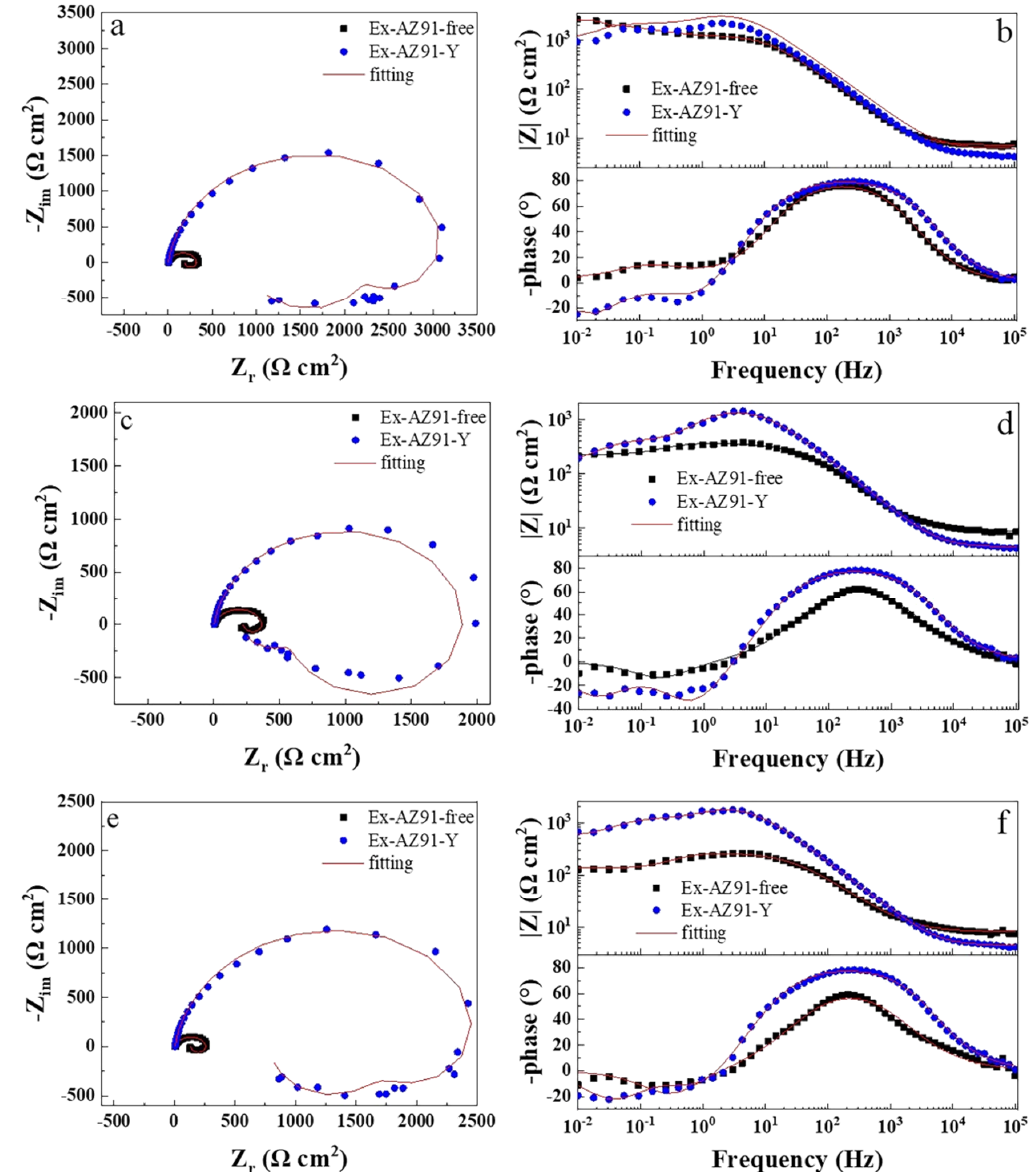
Figure 8. Nyquist and Bode plots of the transversal section of Ex-AZ91-free and Ex-AZ91-Y alloy, ( a , b ) 2 h, ( c , d ) 8 h, and ( e , f ) 12 h.